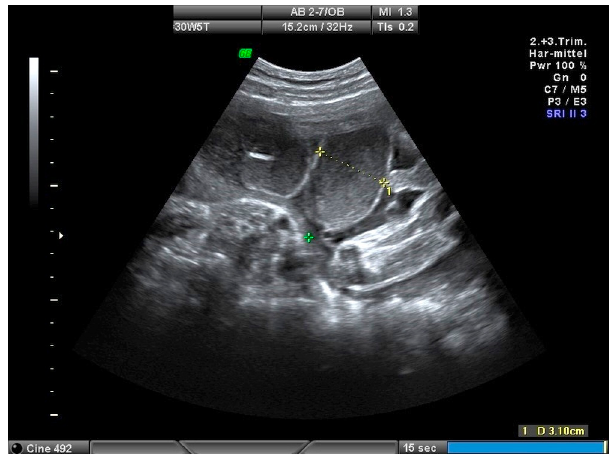
Figure 1. Gastroschisis: example of intraabdominal bowel dilatation (IABD).